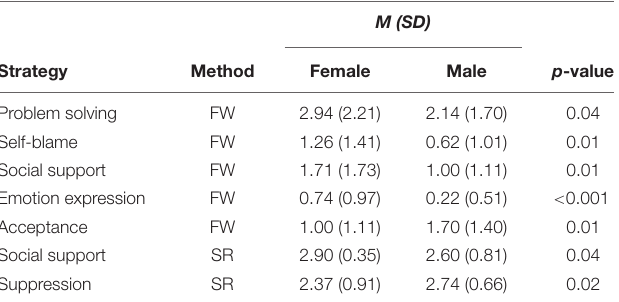
TABLE 5 | Means and standard deviations for gender differences in total individual strategy use.